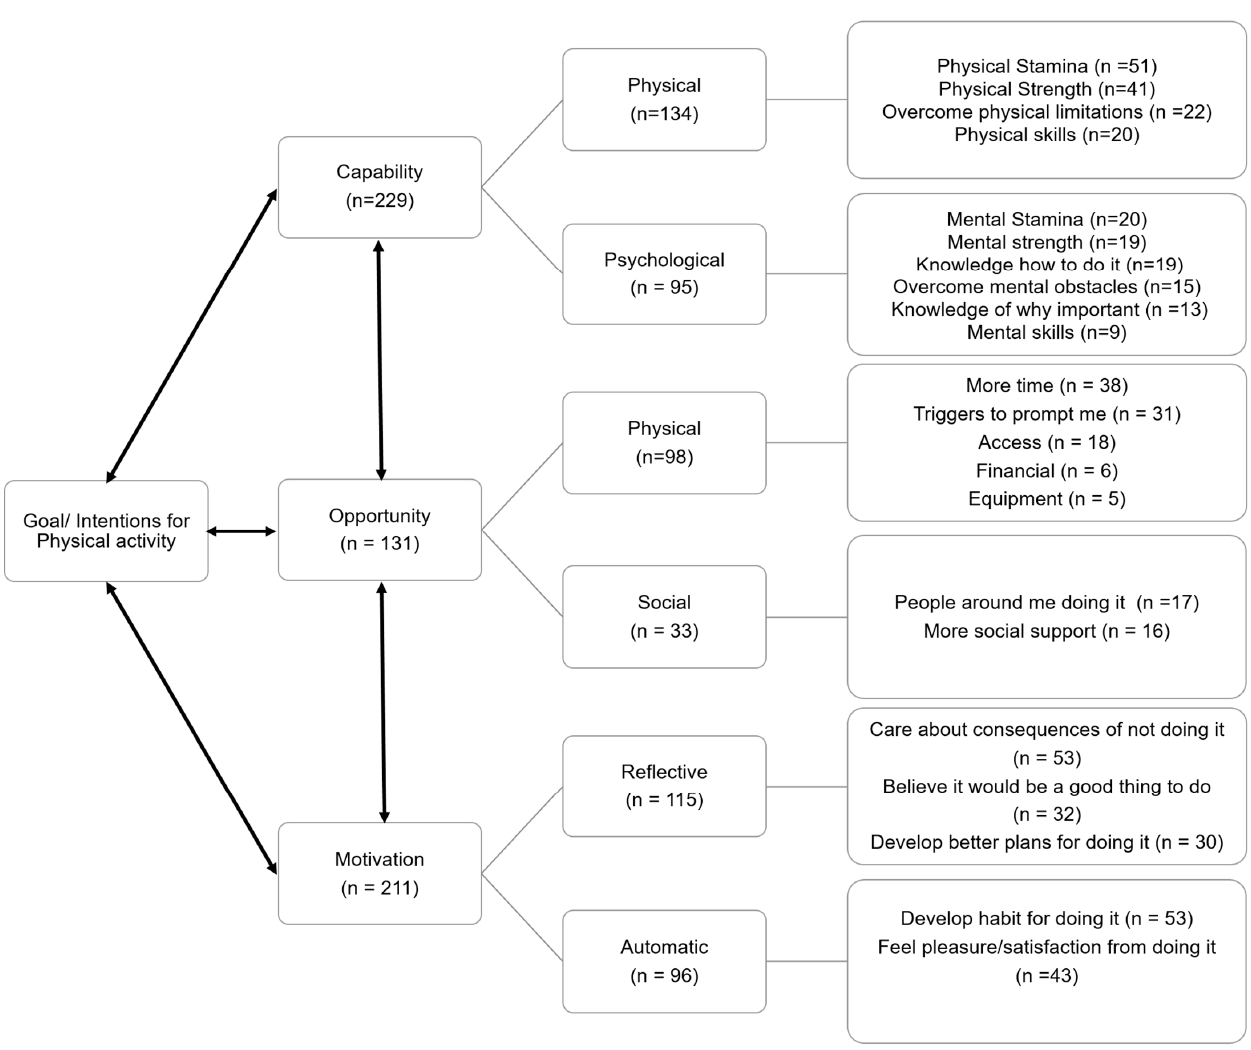
Figure 3. Perceived Capability, Opportunity and Motivation barriers to intended post COVID-19 restrictions PA behaviour.